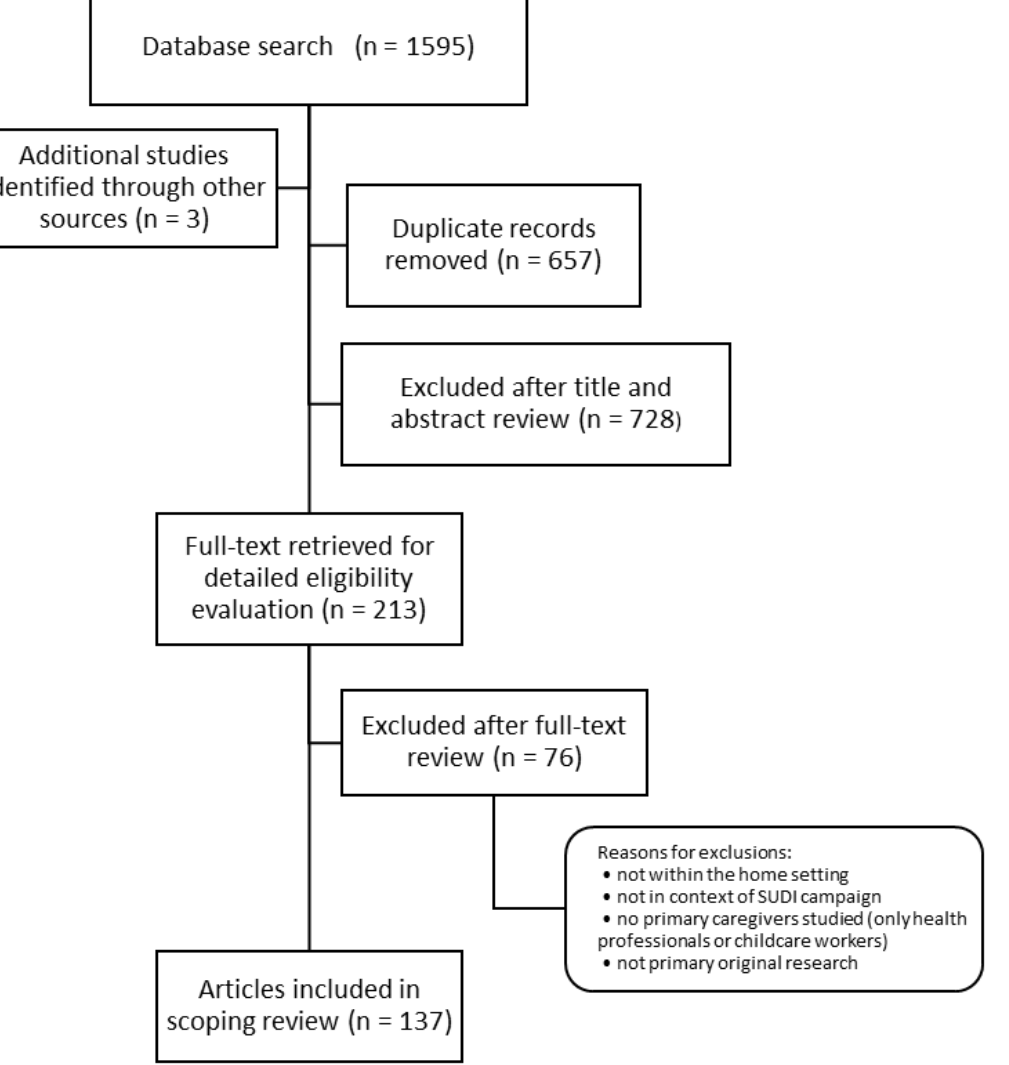
Figure 1. Study selection (PRISMA